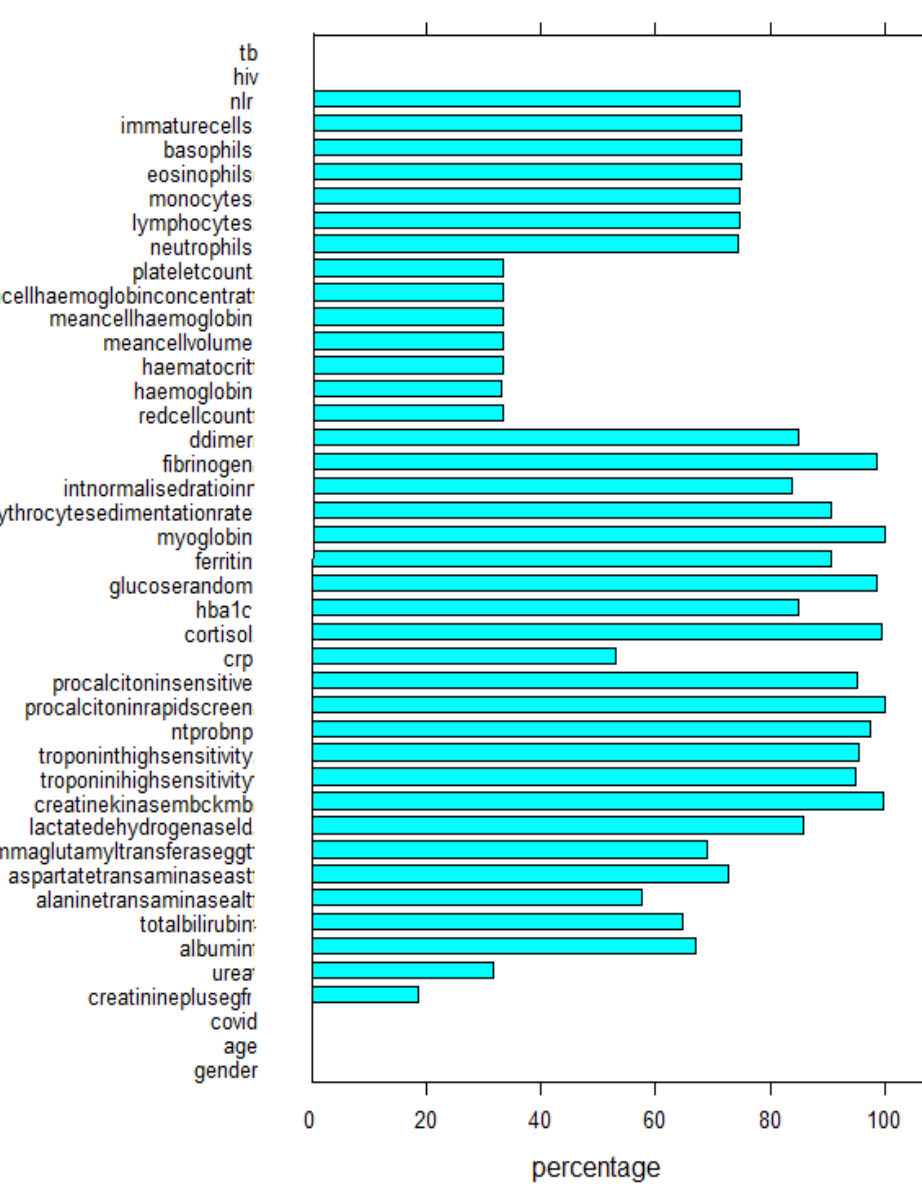
Figure 12. Percentage of missing values in the data per